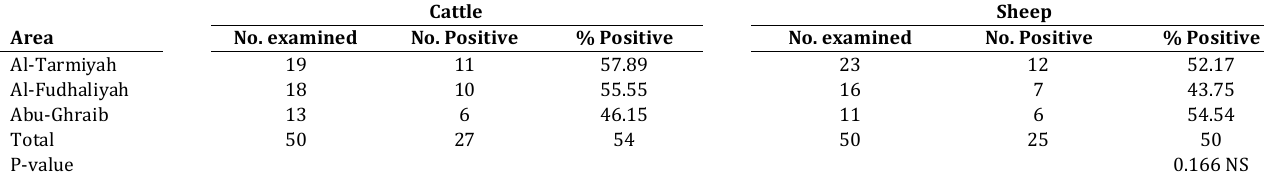
Table 4. Infection rate of Entamoeba spp in cattle and sheep according to area of study